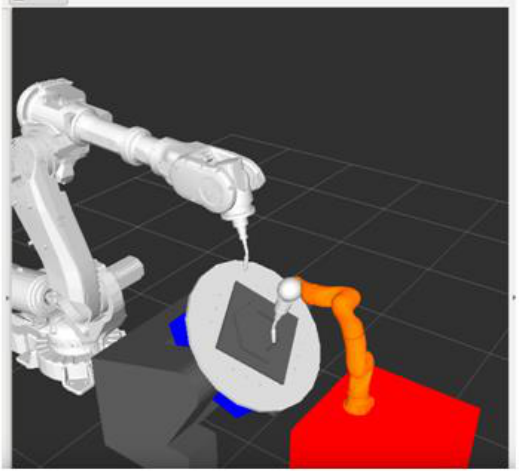
Figure 16. Simulation of robot collaboration.